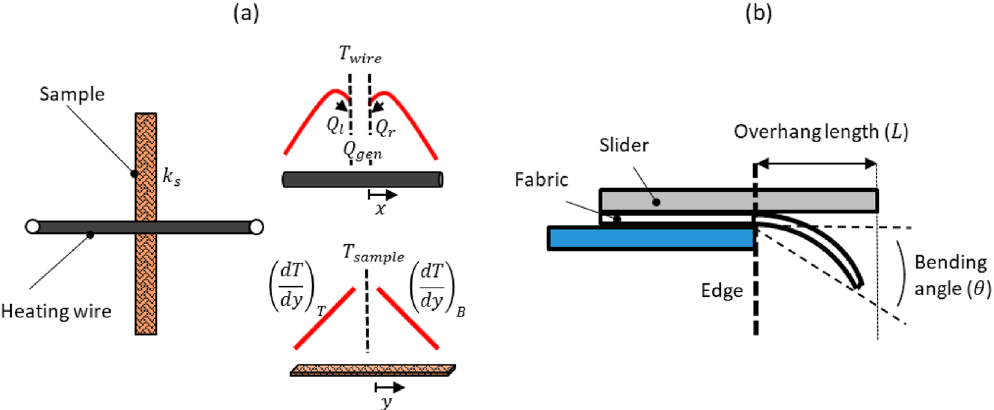
Figure 3. ( a ) Schematic representation of the thermal metrology setup showing a heating wire orthogonally oriented in contact with the test sample to be measured (left). Representative tempature profiles of the wire and sample shown (right) are captured using an infrared microscope. Heat rates ( Q l and Q r ) are determined from the wire temperature profile, and the temperature